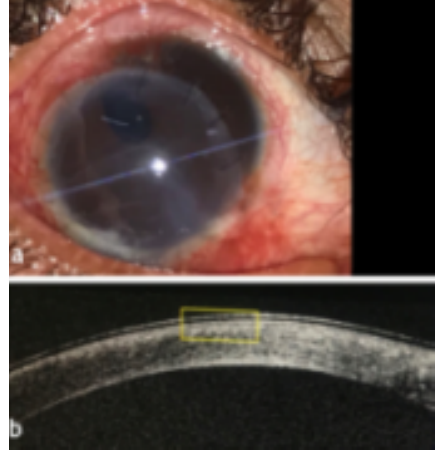
Figure 3: Postoperative pictures; (a) graft sutured to host with 10-0 nylon; (b) OCT shows minimal interface